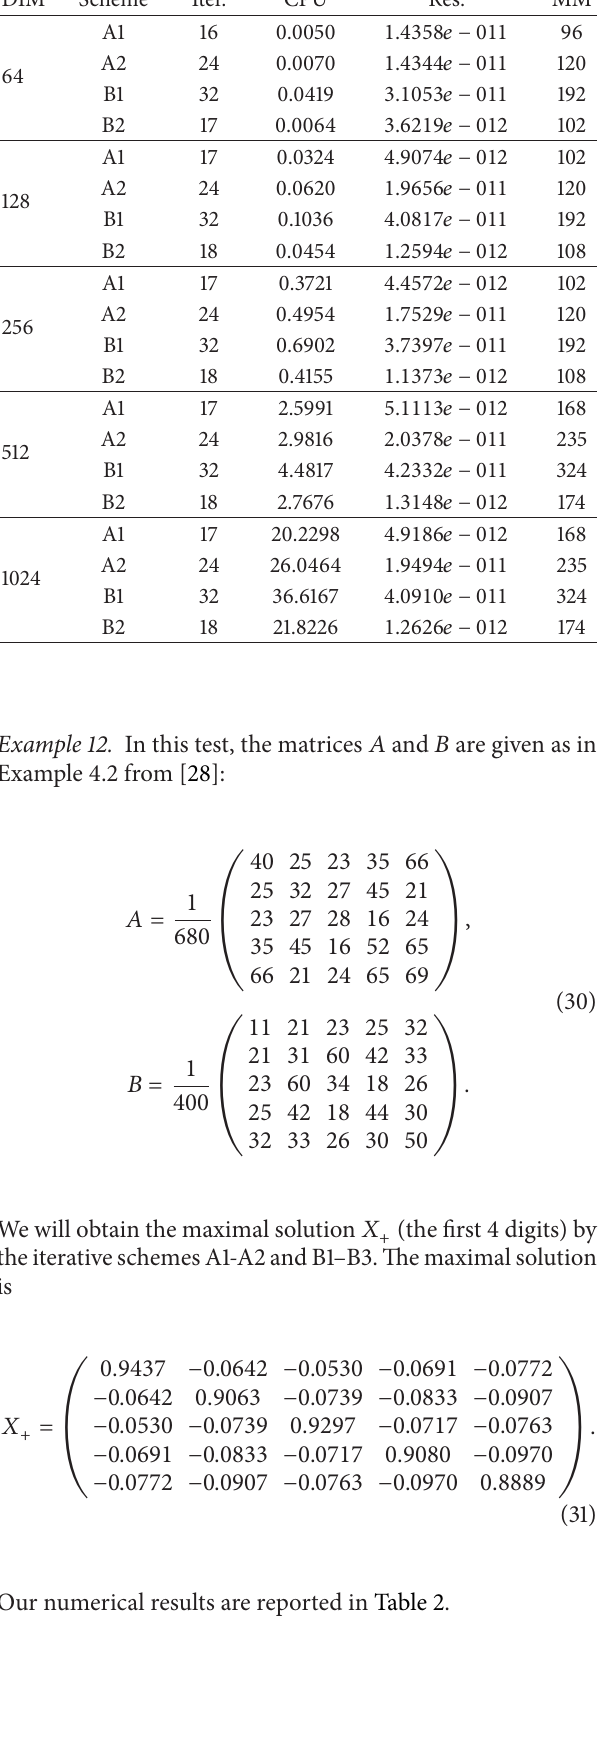
Table 3: Numerical results of Example 13. Scheme